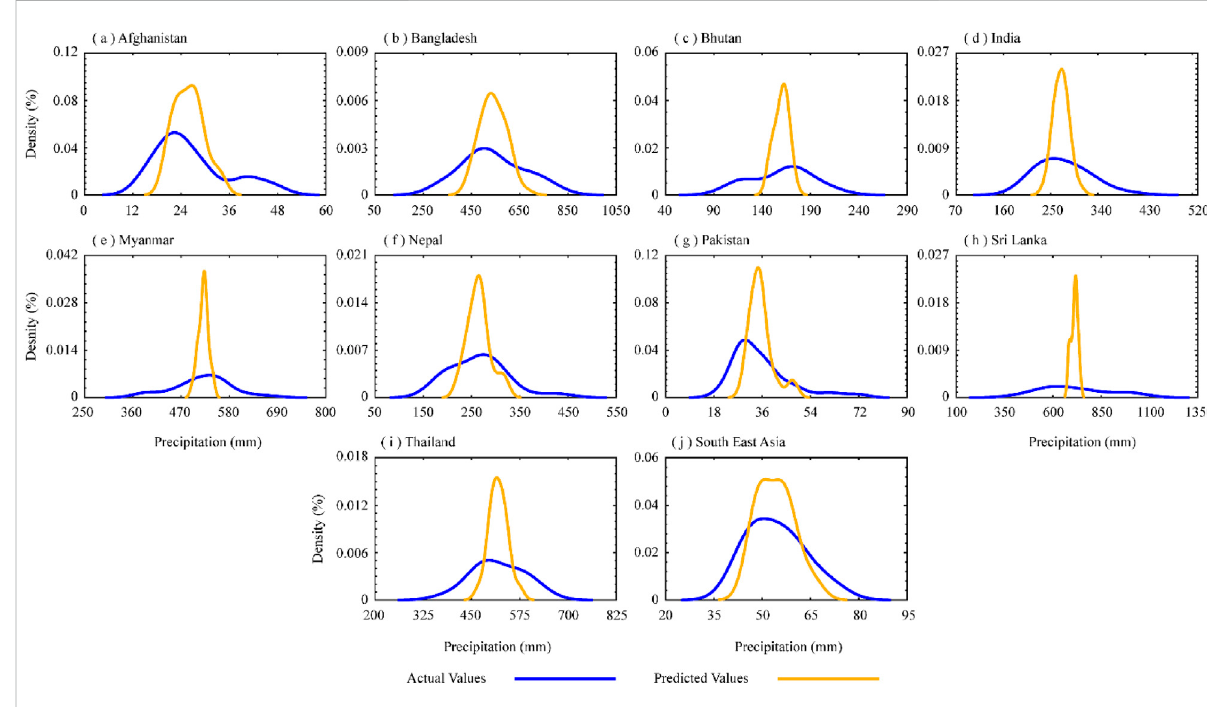
FIGURE 12 Probability distribution function of fall actual and predicted precipitation values during 1981 – 2020.